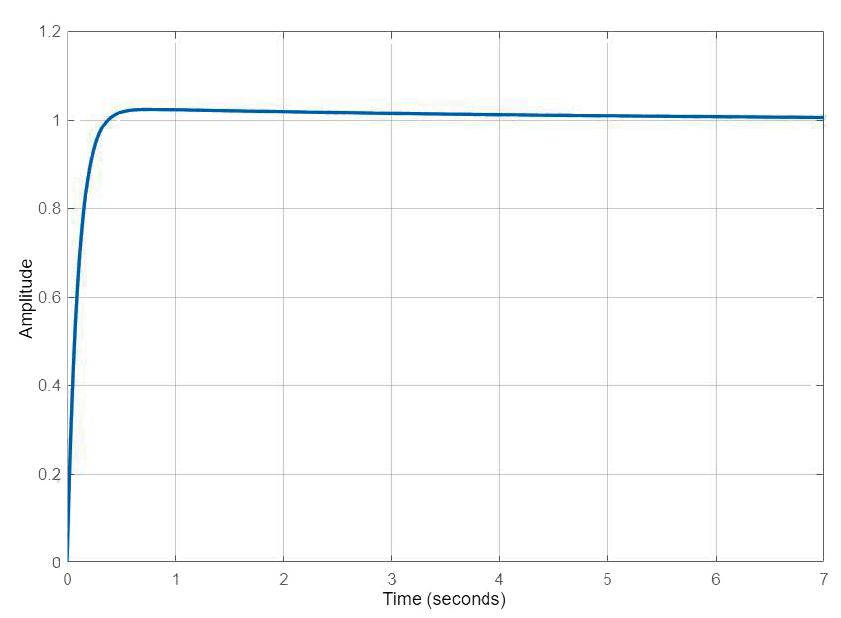
Figure 5. Altitude response to the second control